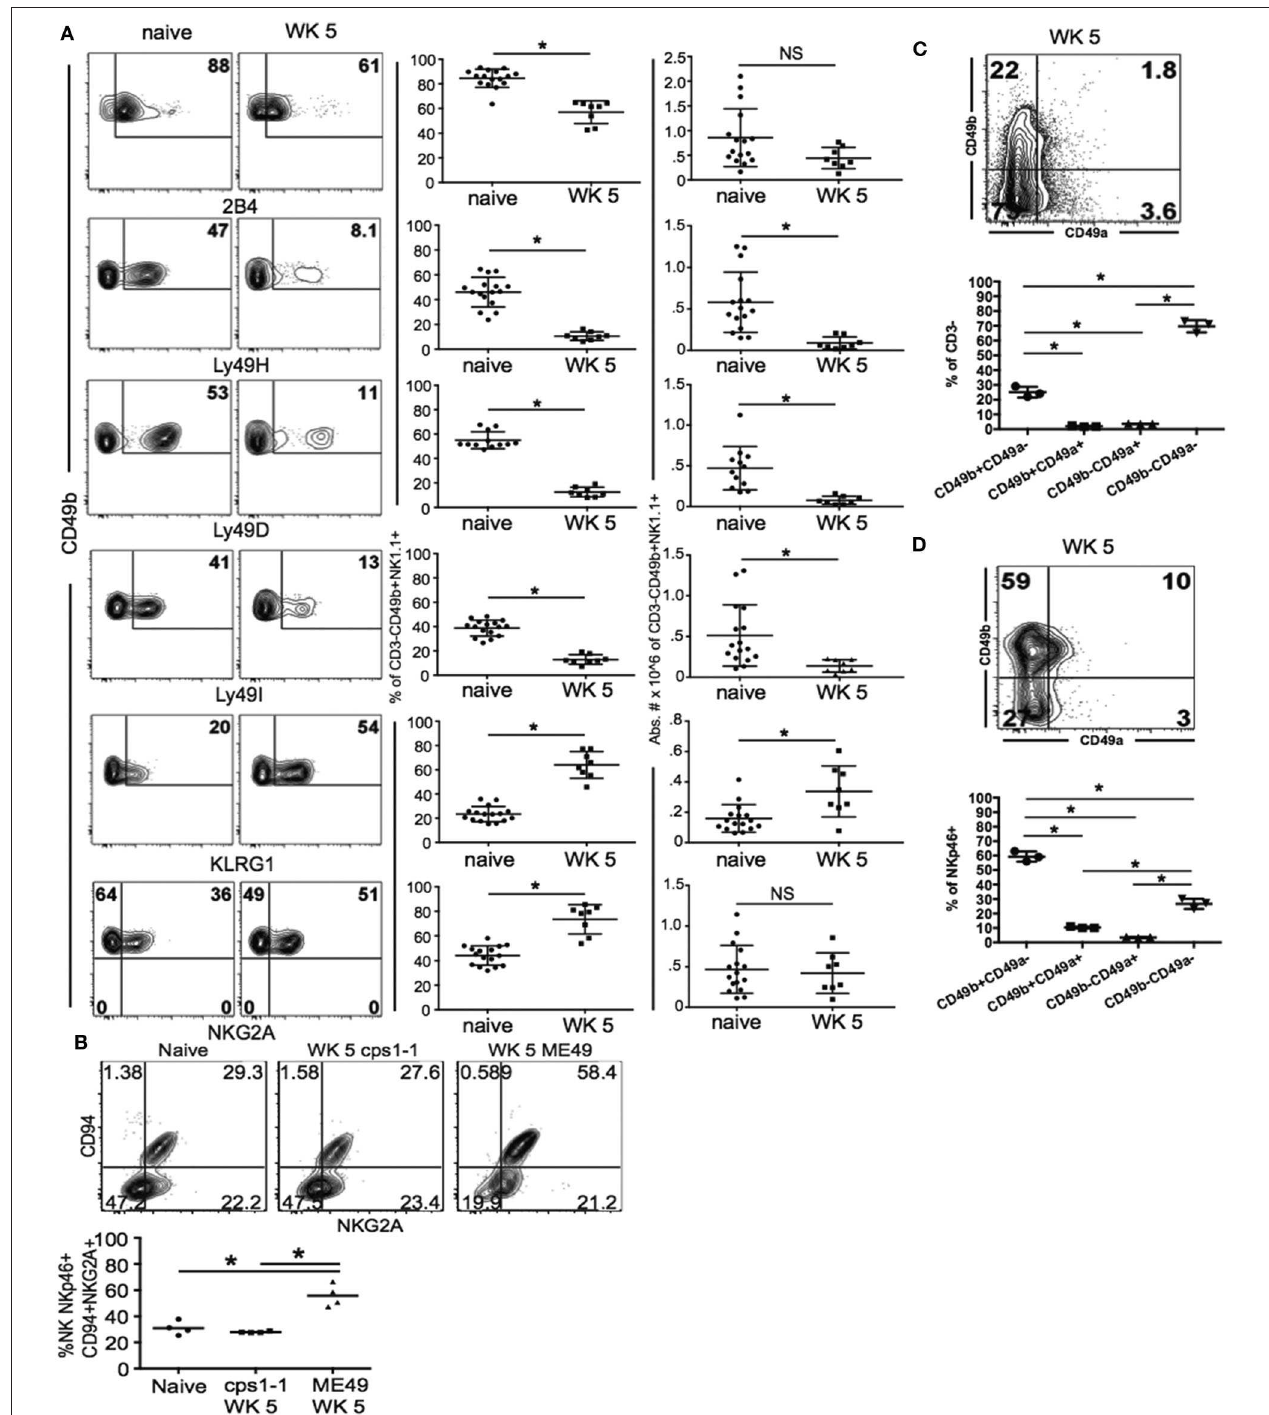
FIGURE 5 | NKp46 + NKG2A + KLRG1 + NK cells are enriched in spleen during chronic T. gondii infection. C57BL/6 mice were orally infected with 10 cysts of ME49 and analyzed for the NK cell receptors 2B4, Ly49H, Ly49D, Ly49I, KLRG1, CD94, and NKG2A by flow cytometry. (A) Contour plots present the frequency of CD49b + × receptor + cells comparing naïve animals to week 5 post infection. Graphs show pooled data from 3 experiments of frequency and absolute number of CD49b + Receptor + cells. (B) Mice were infected with either 1 × 10 6 tachyzoites of csp1-1 i.p. or 10 cysts ME49 i.g. At week 5 post infection, lineage-CD49b + NKp46 + cells were analyzed for CD94 × NKG2A. Contour plots present data from one experiment showing frequency of CD94 × NKG2A cell populations. The graph presents